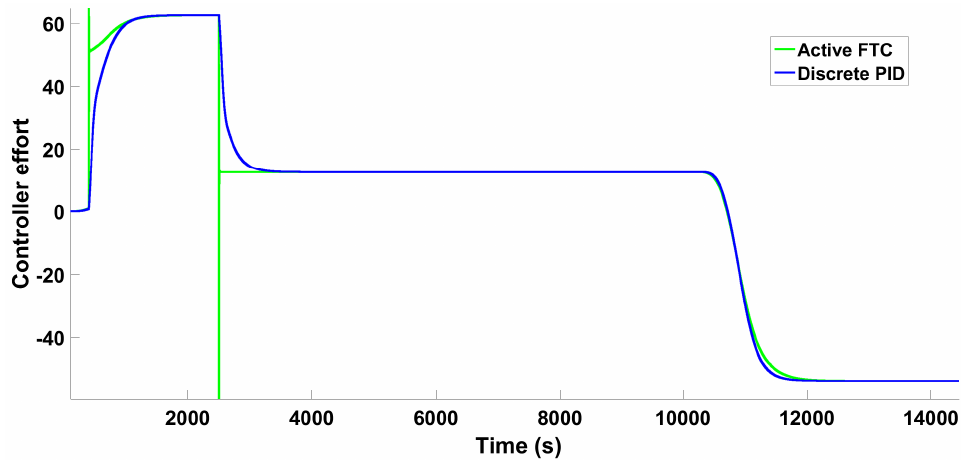
Figure 18. Scenario 1 − Step-type fault: Control signals applied on the reduced model (Hammerstein − Wiener).